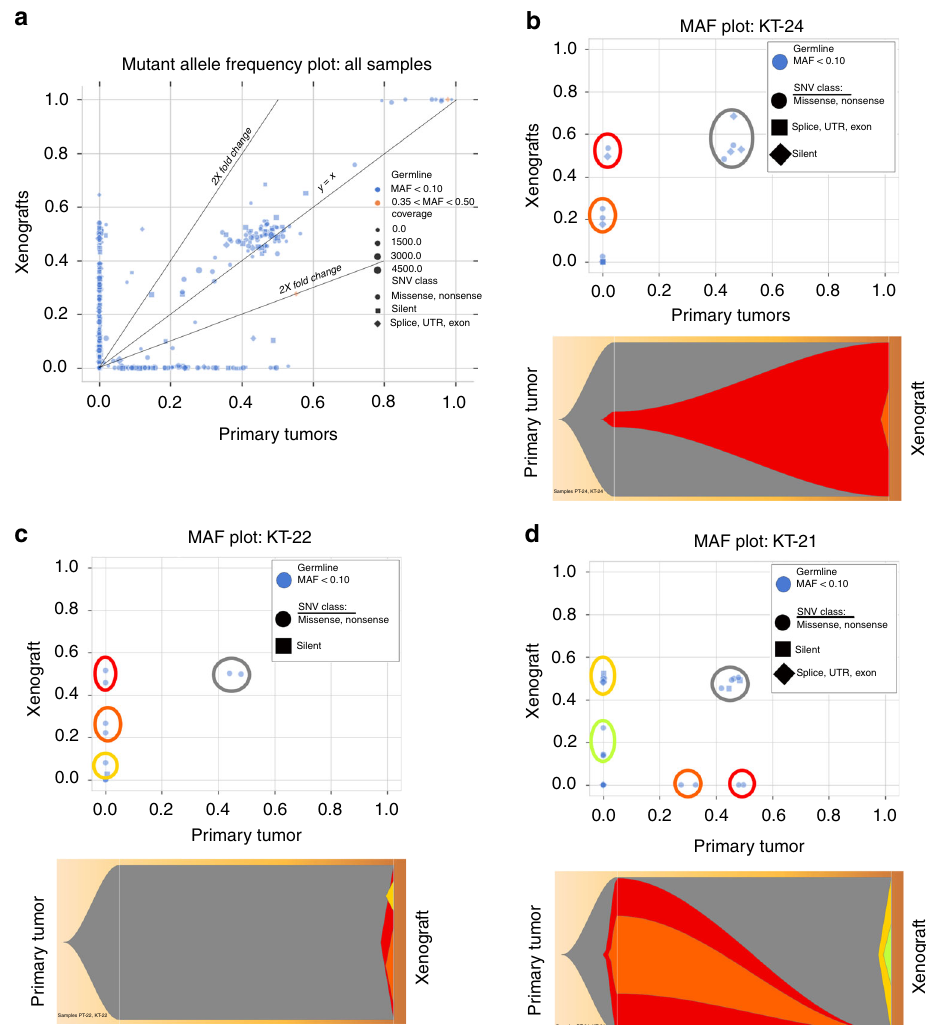
Fig. 4 Subclonal analysis of WTPDX and parent primary tumors. a Mutant allele frequency (MAF) plot of the entire target capture validation sequencing dataset depicts clones of mutant alleles shared between WTPDX and primary tumors (along slope y = x line), clones enriched or depleted in the xenografts (2× fold change lines depicted), and clones represented in the primary tumor or xenograft, but not both (clustered along x and y axes). b MAF and Fish plots show that KT-24 demonstrates maintenance of a major clone from the associated primary tumor (gray), expansion of a minor subclone from the primary tumor into a major clone in the xenograft (red), and the presence of a xenograft-speci fi c subclone (orange). c KT-22 demonstrates maintenance of the major clone from the primary tumor (gray), with emergence of xenograft speci fi c clones (red, orange, and yellow). d KT-21 demonstrates maintenance of the major clone from the primary tumor (gray), loss of clones from the primary tumor (red and orange), and emergence of xenograft-speci fi c clones (yellow and